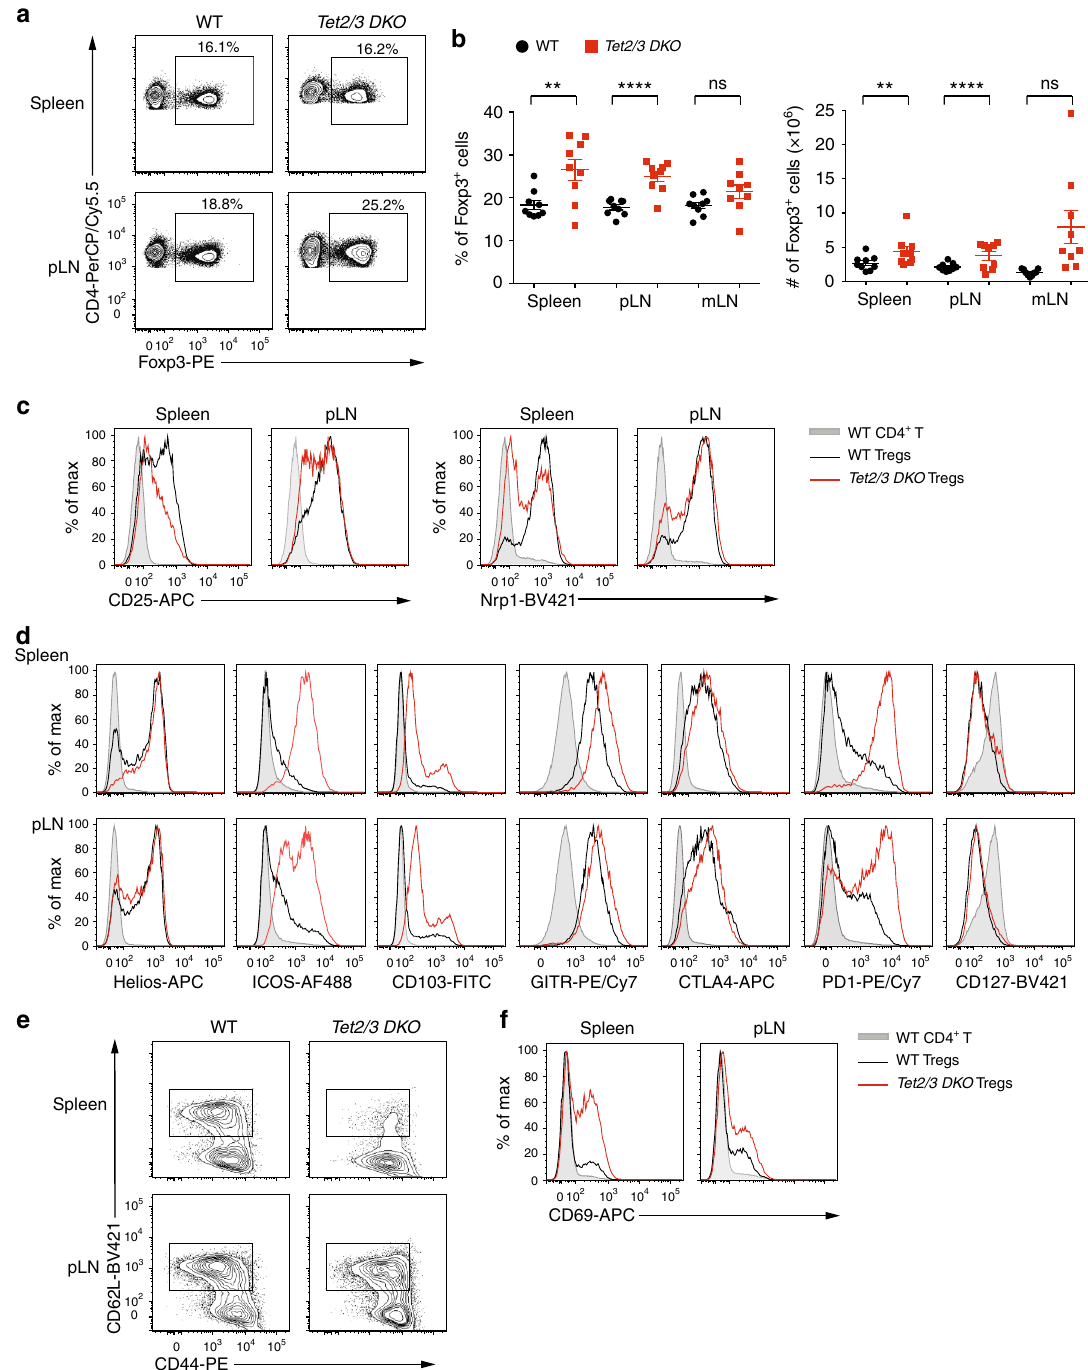
Fig. 2 Characterization of Tet2/3 -de fi cient Treg cells. a Representative fl ow cytometry analyses of the percentage of Treg cells (% of Foxp3 + cells in gated CD4 + T cells) in spleen and pLN from WT and Tet2/3 fl / fl Foxp3 Cre DKO mice (13 – 16 weeks-old). b Quanti fi cation of the percentages ( left panel ) and cell numbers ( right panel ) of Treg cells in spleen, pLN and mLN from WT and Tet2/3 fl / fl Foxp3 Cre DKO mice (13-16 weeks old, n = 9). c – f Flow cytometry analysis of Tet2/3 -de fi cient Treg cells from spleen and pLN for the expression of CD25 and Nrp1 ( c ); Helios, ICOS, CD103, GITR, CTLA4, PD1 and CD127 ( d ); CD62L versus CD44 ( e ); and CD69 ( f ). Shown are WT CD4 + T cells (shaded gray); WT Tregs (black line); DKO Tregs (red line). Statistical analysis was performed using two-tailed unpaired student ’ s t test (* P < 0.05, ** P < 0.01, *** P < 0.001, **** P < 0.0001). Error bars show mean ± s.d. from at least